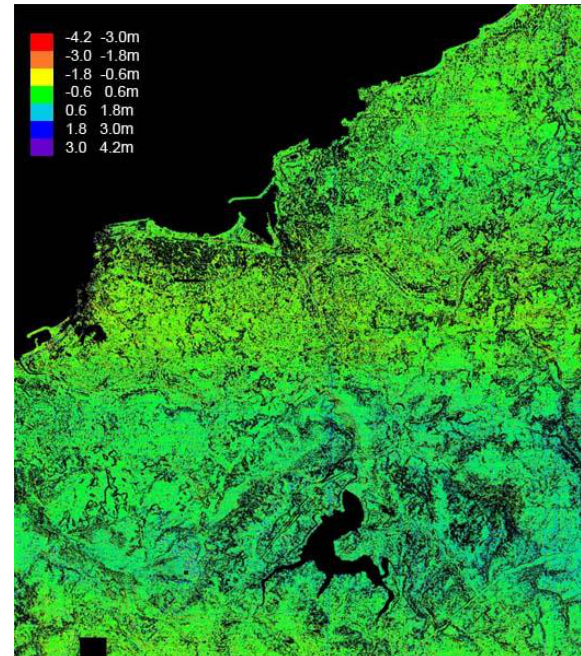
Figure 17. Colour coded height differences of the filtered DSM 283-284 against 269-284